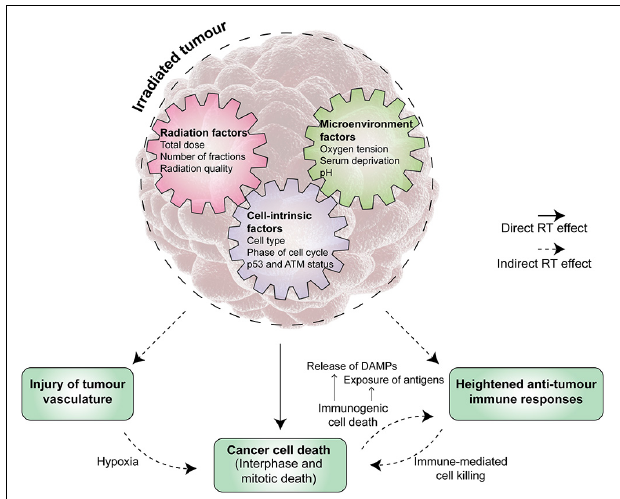
FIGURE 1 | The anti-tumour activity of radiation therapy (RT) is multi-faceted. Tumour irradiation induces both direct and indirect effects in controlling the tumour. Direct effects are the result of significant radiation-induced DNA damage in cancer cells leading to their death, which may occur at various time points after the initial irradiation event. Radiation therapy (RT) also exerts anti-tumour activity via indirect effects, which include, but are not limited to, injury of tumour vasculature and priming of host anti-tumour immune responses. A range of factors influence the triggering and magnitude of these effects, broadly falling into cell-intrinsic, radiation, and microenvironment factors. A deeper knowledge of the underpinning mechanisms and their interplay will reveal opportunities for enhancing the overall anti-tumour activity of RT. ATM, ataxia-telangiectasia mutated. DAMP, danger associated-molecular